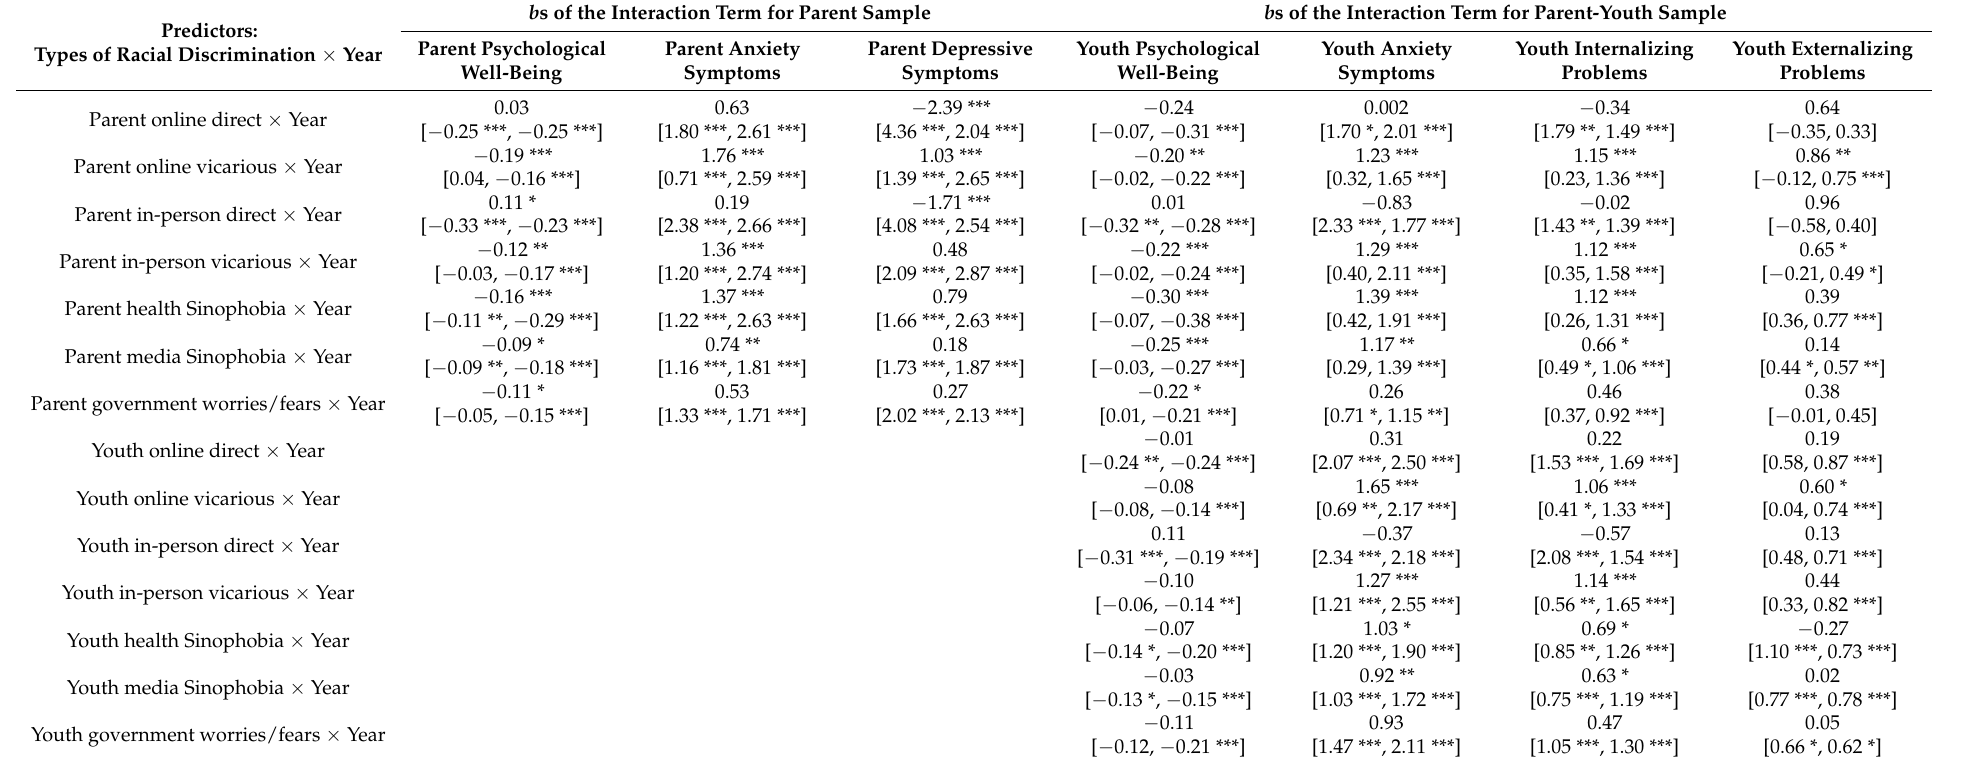
Table 4. Results of the moderated multiple regression